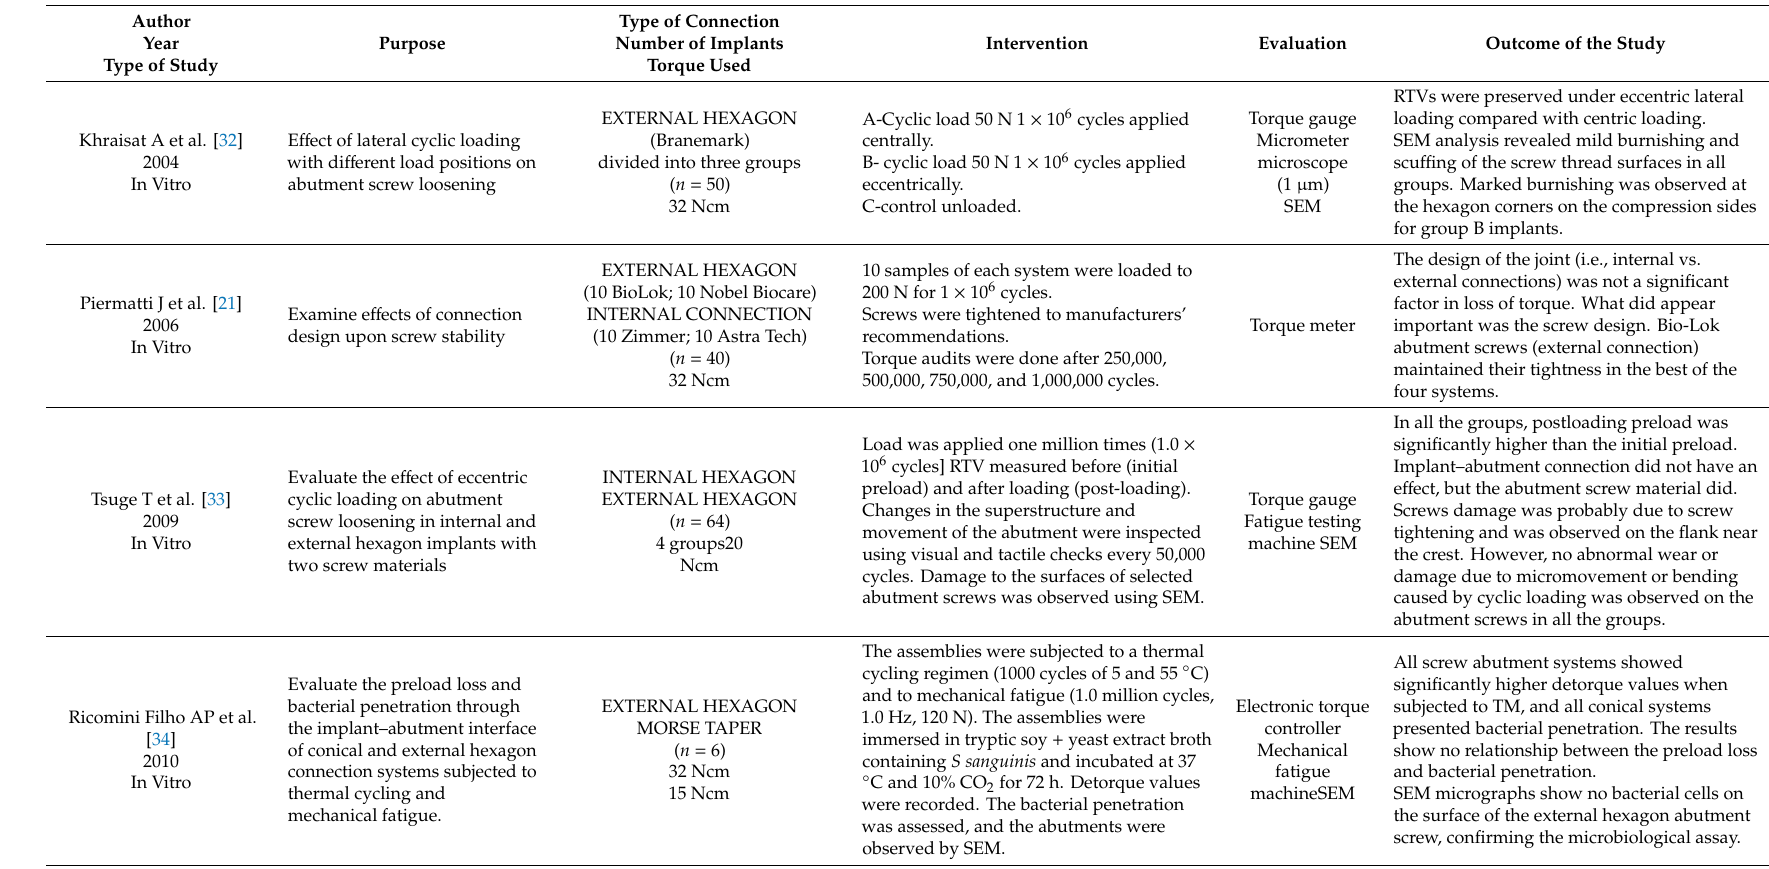
Table 1. Summary of included